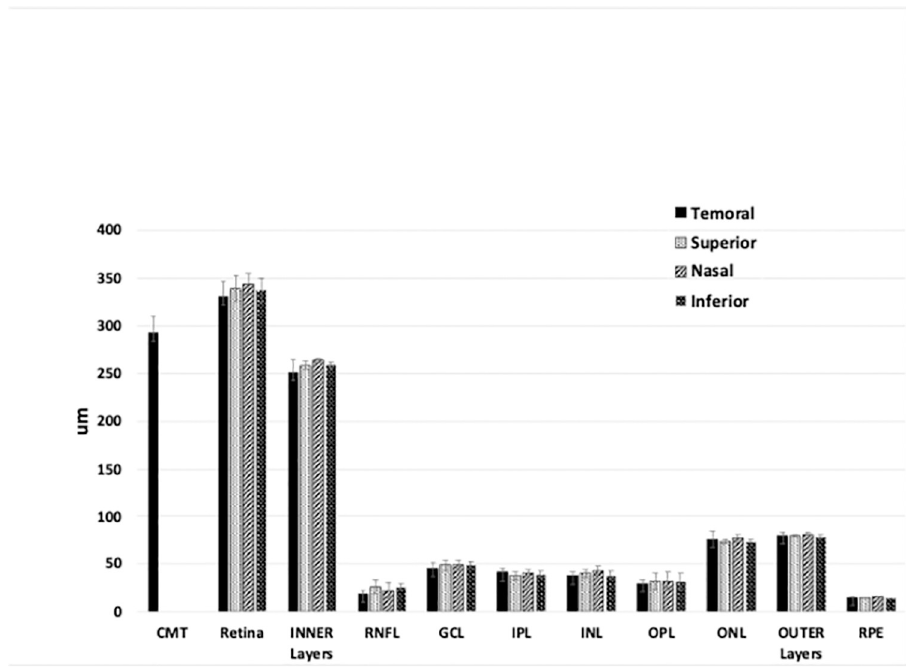
Fig 2. Normal retinal layer thicknesses in the 3 mm quadrants from non-BRAO eyes (mean ± std. dev. error bars). Average age = 64.9 ± 6.3 years (9), all non-Hispanic, ratio of male/female 2:1. (See S1 Table for absolute